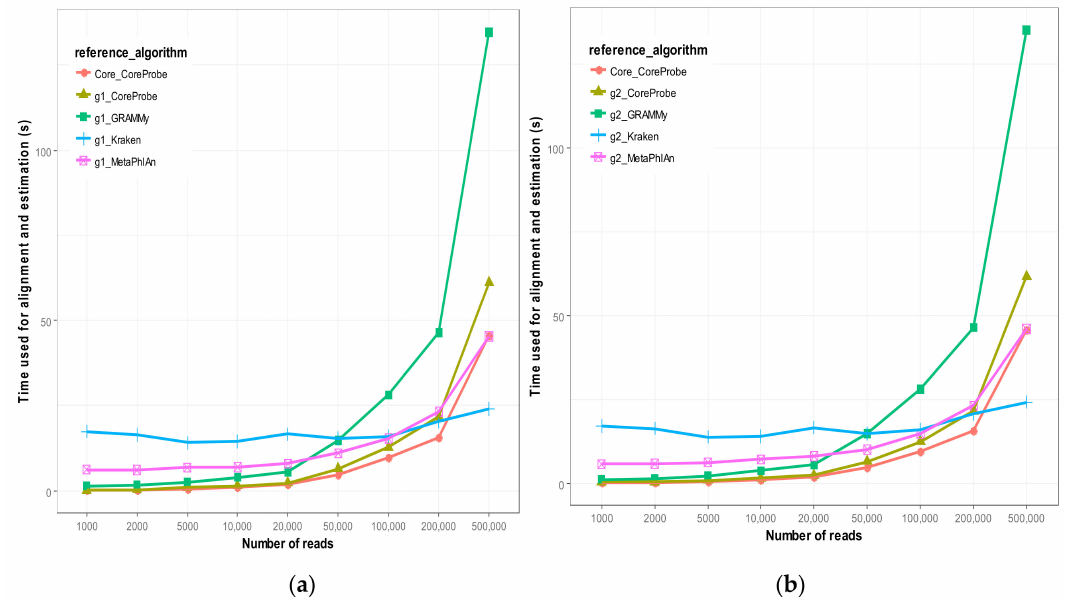
Figure 4. The time used for each algorithm. ( a ) The time used for each algorithm in different reads capacities with g 1 as the reference genome. ( b ) The time used for each algorithm in different reads capacities with g 2 as the reference genome. The abscissa represents the different metagenome simulation datasets of the reads capacity, and the vertical coordinate is the time spent on the calculation process of each